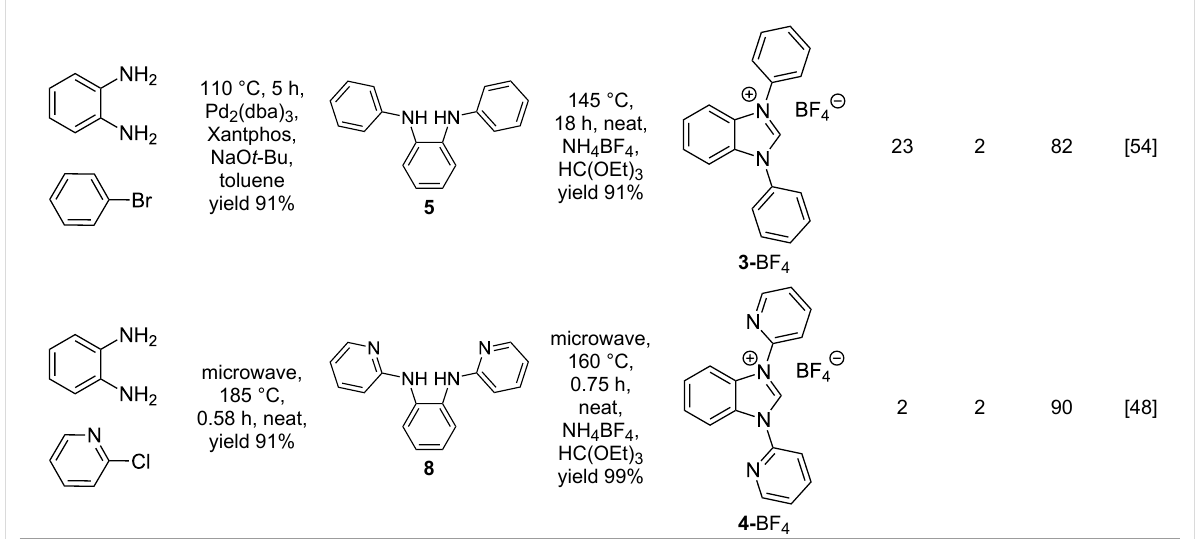
available for 3 -Cl and 4 -Cl, Table 1 suggests that the introduc- tion of the TMSCl–triethyl orthoformate reagent has advan- tages in terms of overall yields and reaction times. The overall achieved yield of 16% for 2 -Cl is indeed low, but the short